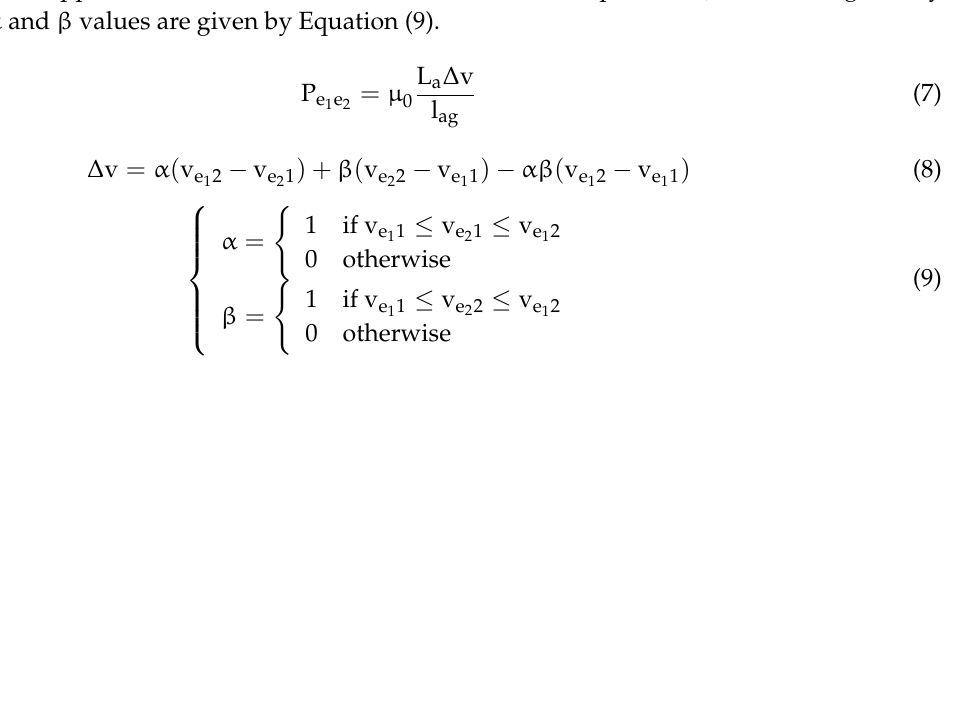
Figure 23. Armature end-windings modeling.